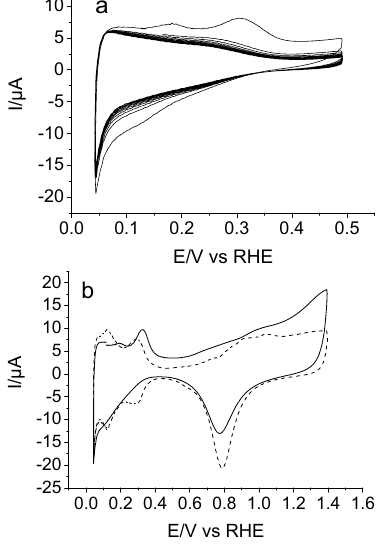
Figure 1. Cyclic voltammograms recorded for a Pt electrode in 1 M of HClO 4 solution containing 10 mM of piperazine. ( a ) Electrochemical behavior within the potential region 0.05–0.5 V (10 cycles); ( b ) Electrochemical response obtained during the first excursion of up to 1.4 V (solid line), and for clean Pt, in 1 M of HClO 4 free of piperazine (dashed line) in the same potential window. v = 50 mV s − 1 in all